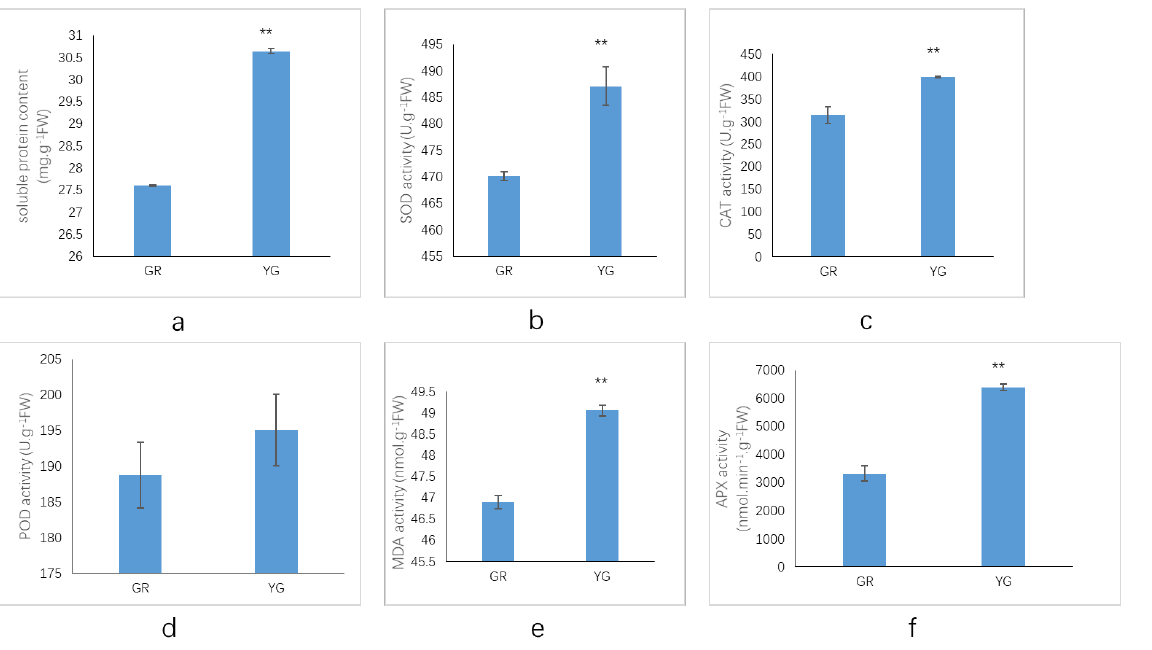
Figure 4. Activities of protective enzymes and MDA contents in green and yellow-green region of leaves of P. tatarinowii ‘Jinyuyuan’. ( a ) soluble protein content. ( b ) SOD activity. ( c ) CAT activity. ( d ) POD activity. ( e ) MDA activity. ( f ) APX activity. ** Indicates significance at the 0.01 level. GR indicates for the green region of the leaf, and YG indicates the yellow-green region of the leaf. A unit (U) is defined as giving 50% inhibition. APX activity unit definition: one enzyme activity unit oxidized 1 nmol AsA per g of tissue per minute.